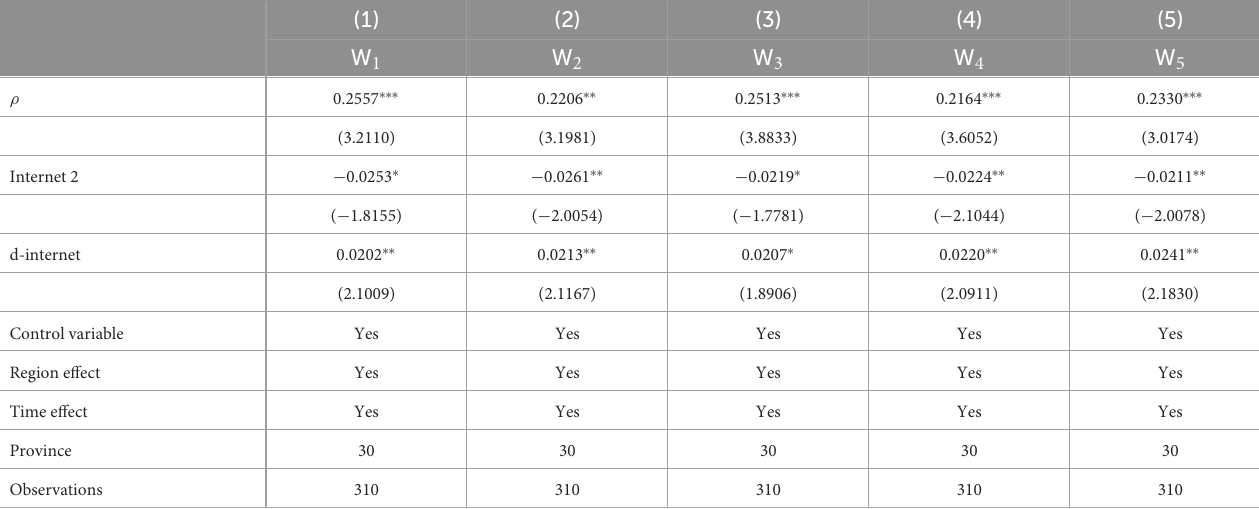
TABLE 7 Robustness test